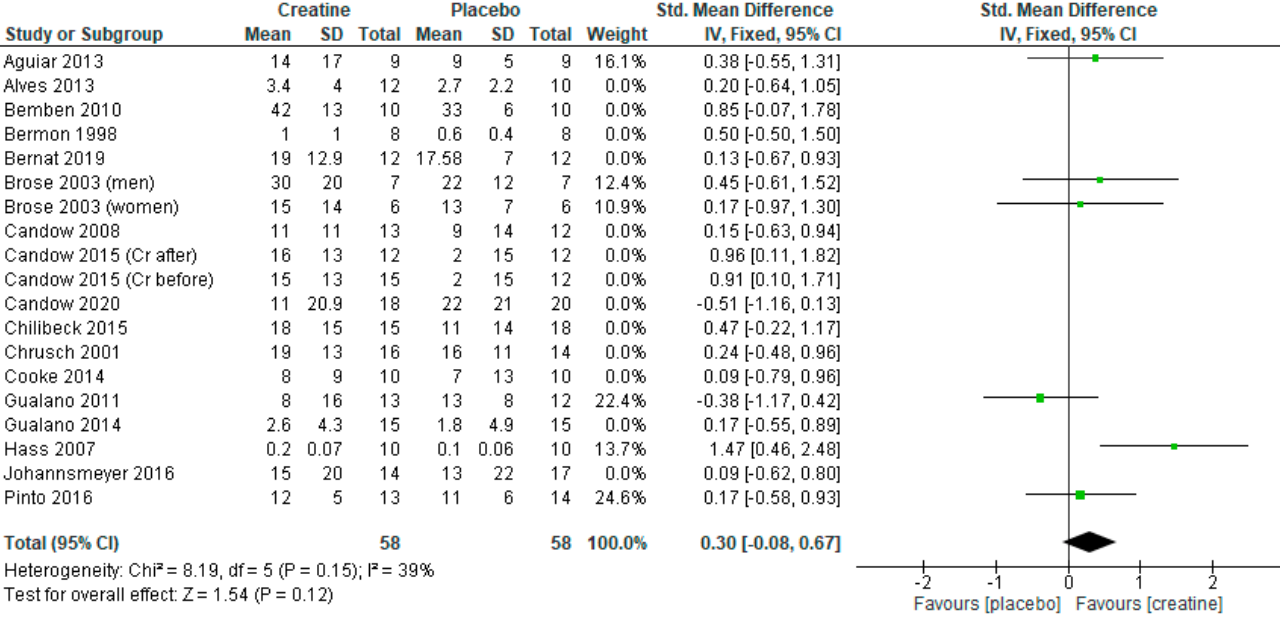
Figure 3. Forest plot of lower-dose creatine studies ( ≤ 5 g/day) on chest press strength with exclusion of creatine loading studies.